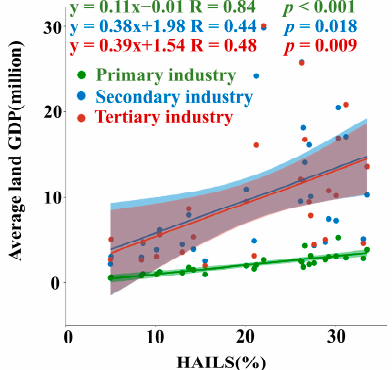
Figure 6. Correlation between average land GDP and the HAILS: ( a ) average land GDP; ( b ) average land GDP of primary industry, secondary industry, and tertiary industry.